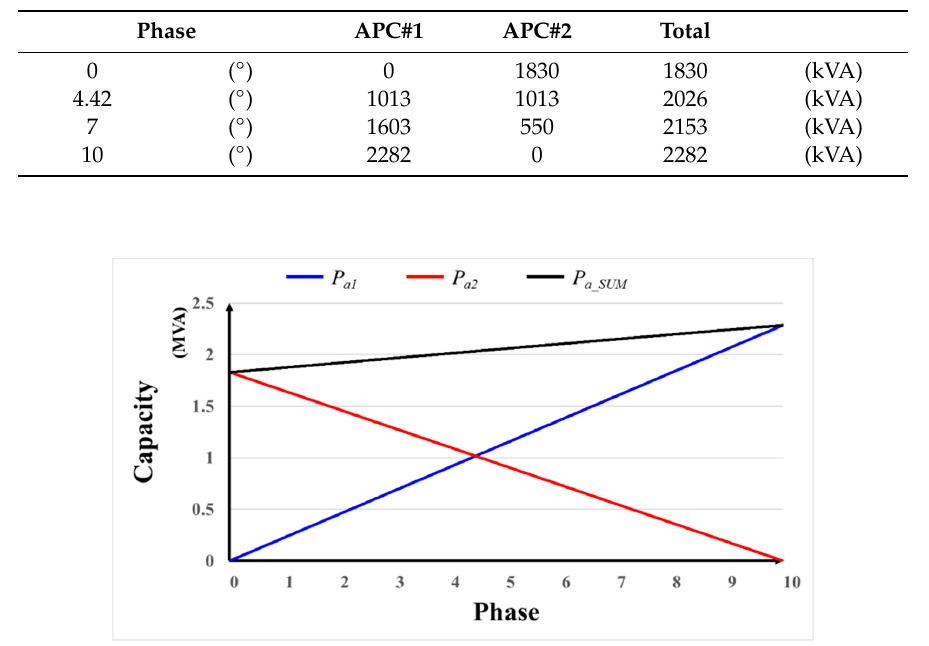
Figure 7. Total APC capacity according to load impedance and power factor variation.